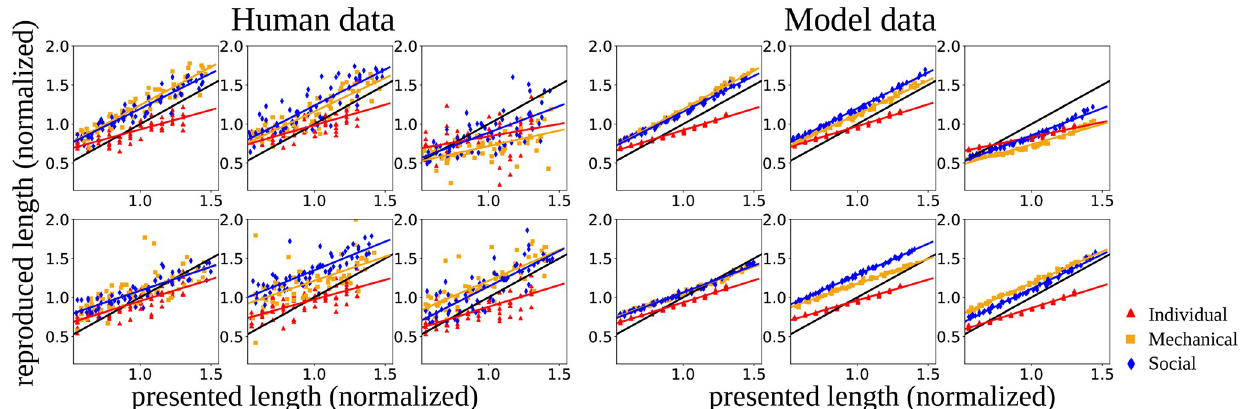
Fig 2. The reproduced lengths plotted against the presented lengths, where lengths were calculated in the normalized space of trajectories. Original human data (left) is compared with the corresponding mean predictions produced by one example network (right) for six randomly chosen participants. Lines in both plots correspond to the regression lines extracted from the human data or the model data, respectively. The black line shows the identity line.